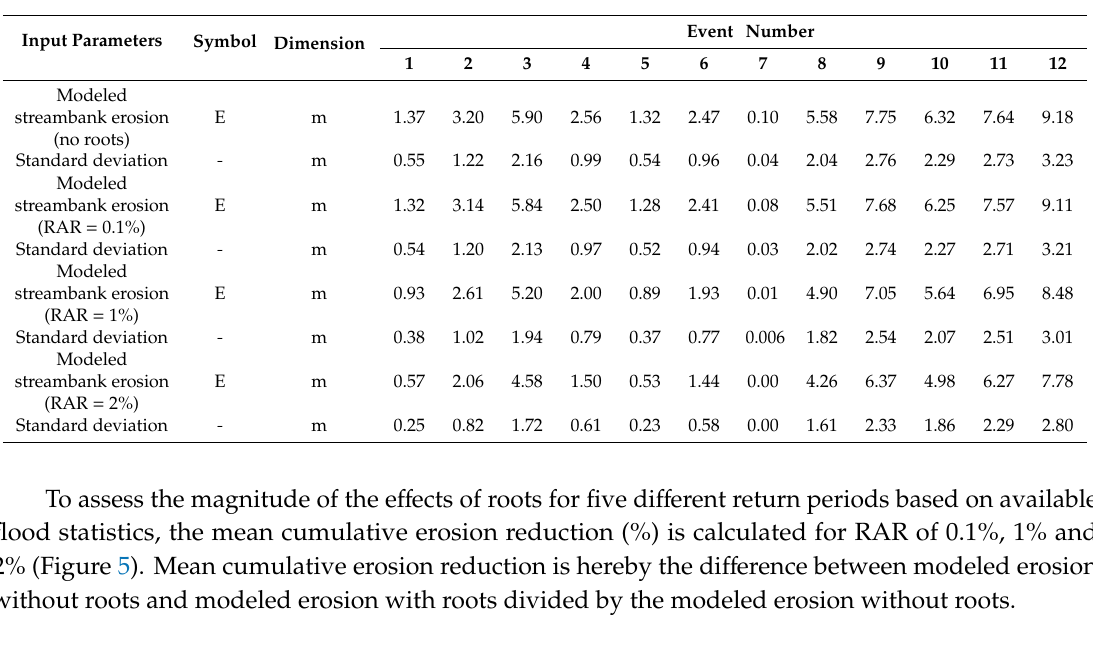
Table 7. Cumulative erosion reduction for the Thur River catchment considering different return periods and root area ratios.